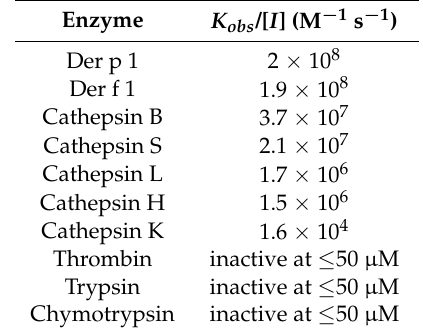
Table 2. Measured activity of ADZ 50,000 against Der p 1, Der f 1, and a panel of off-target cysteine and serine